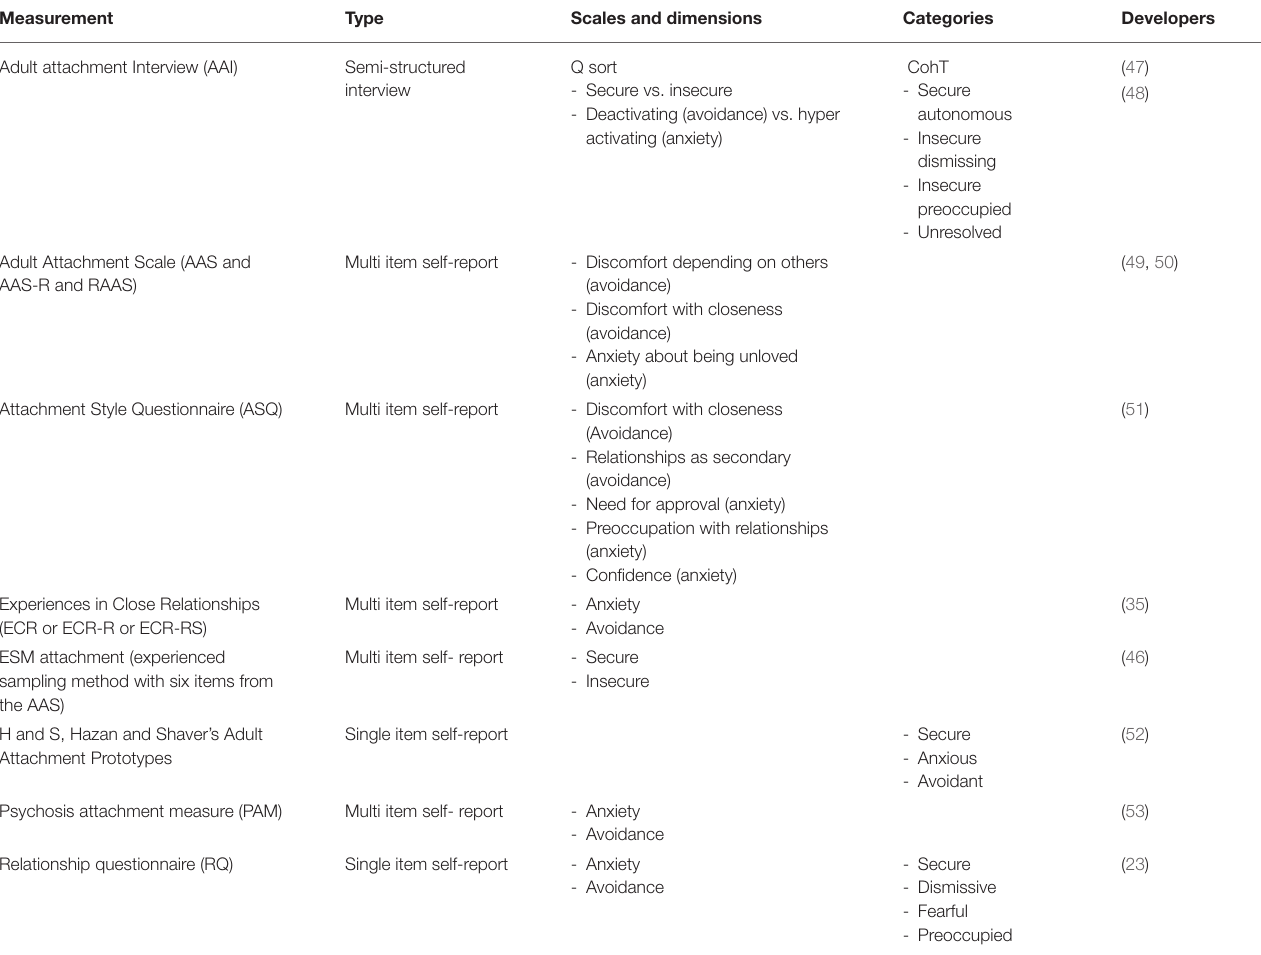
TABLE 1 | Instruments for measuring